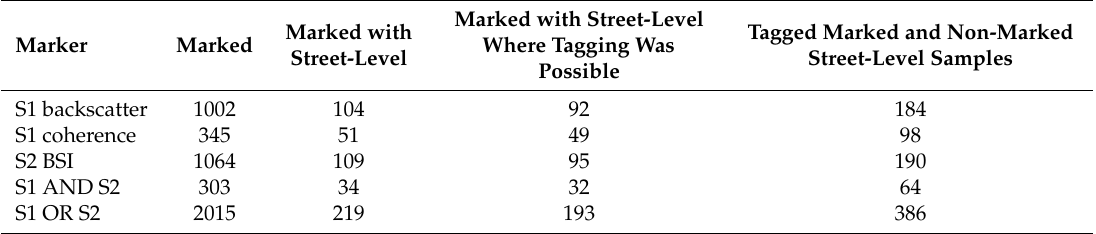
Table 12. Street-level imagery samples’ distribution, which were tagged to assess the markers. The same number of parcels are sampled in marked and non-marked categories.